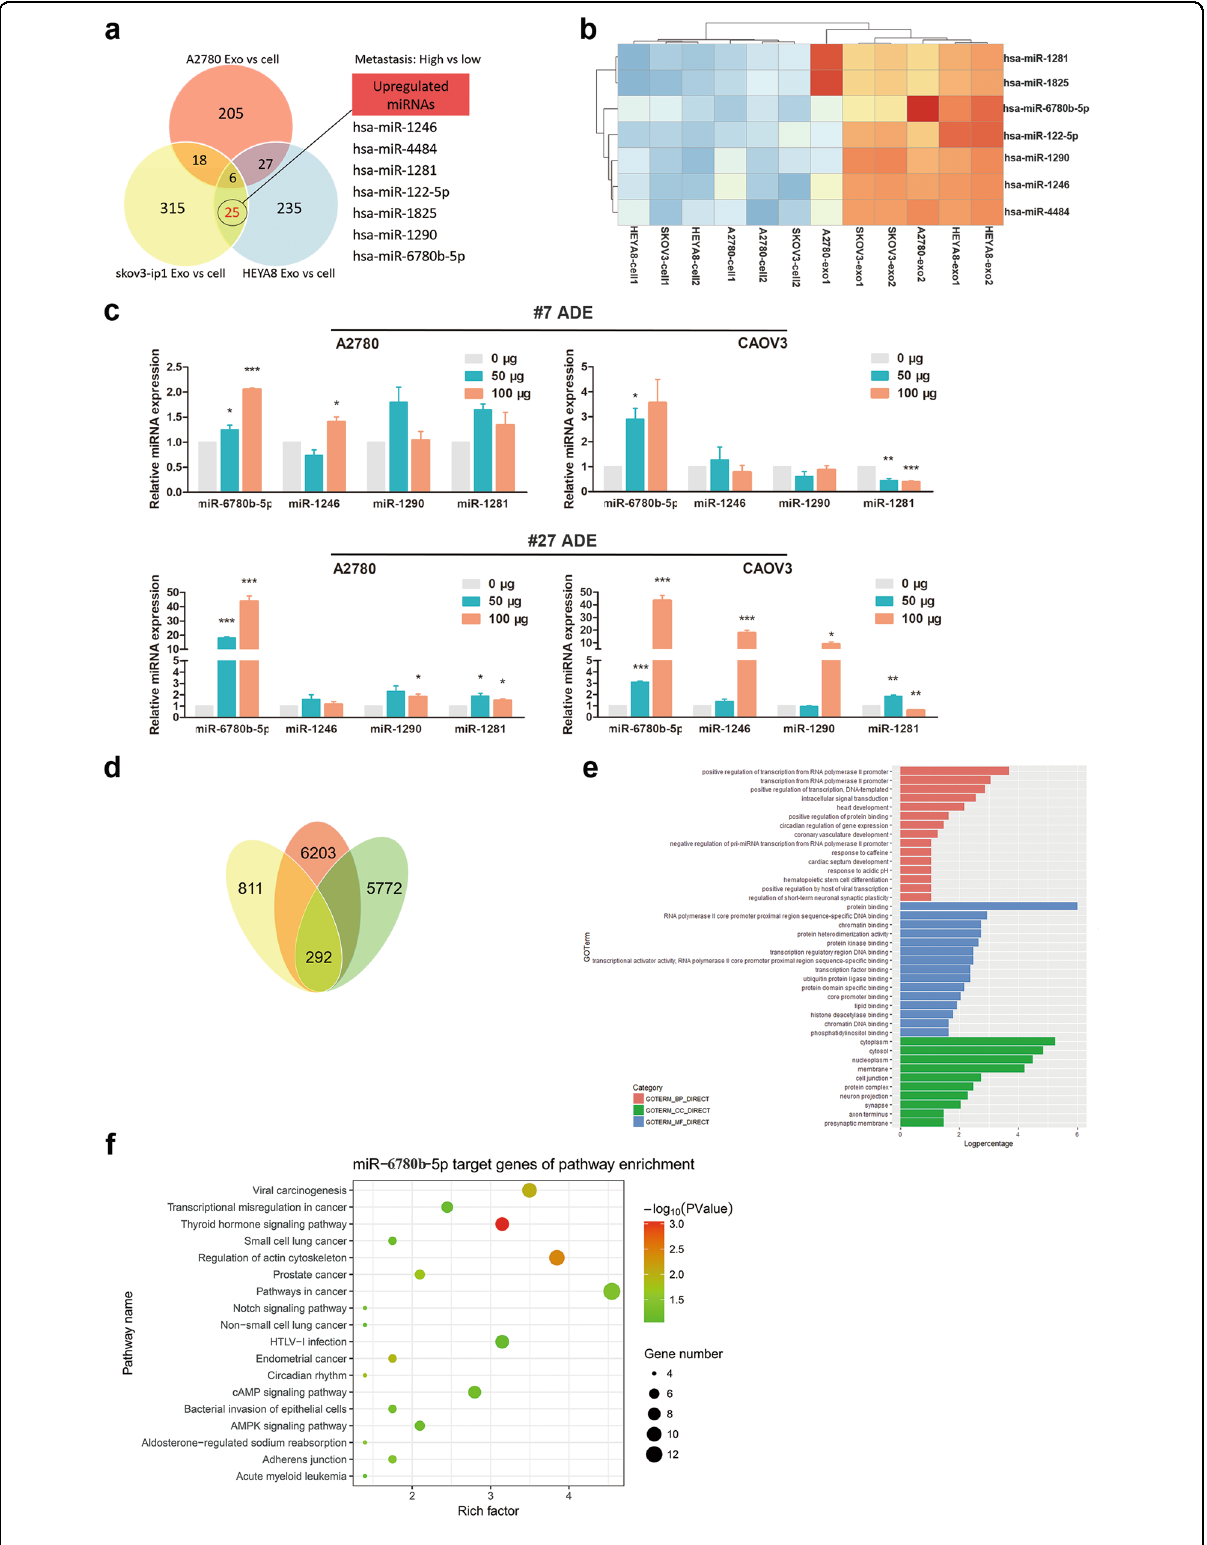
Fig. 5 (See legend on next